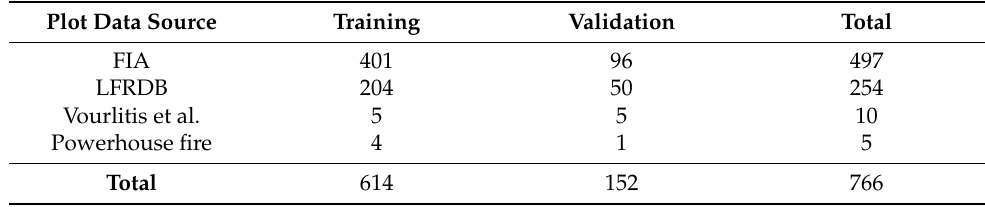
Table 2. Counts of plots used by data source (see text for data source descriptions) for model training and validation. FIA, USFS Forest Inventory and Analysis; LFRDB, LANDFIRE Reference Database. Plot Data